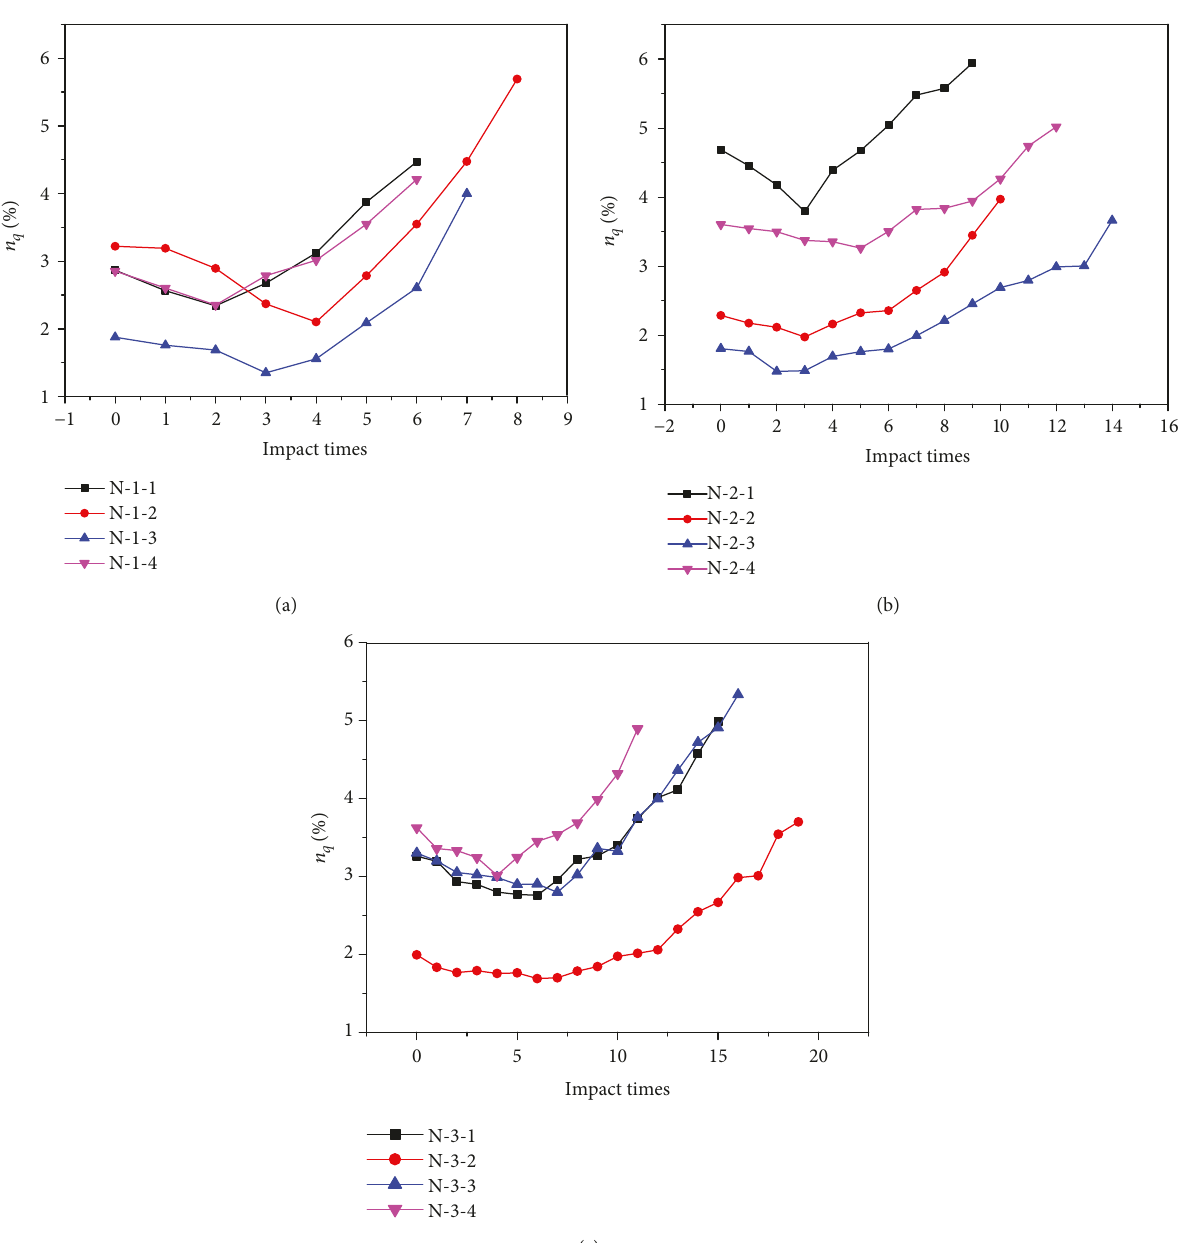
Figure 9: The relationship between e ff ective porosity and impact